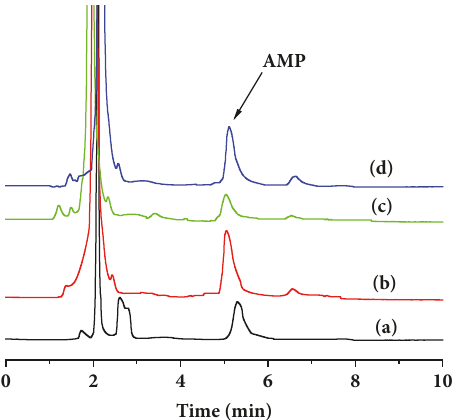
Figure 11: Chromatograms of egg samples processed on different solid phase extraction (SPE) columns: (a) C 18 -SPE cartridge, (b) MIPs-SPE cartridge, (c) NIPs-SPE cartridge, and (d) standard